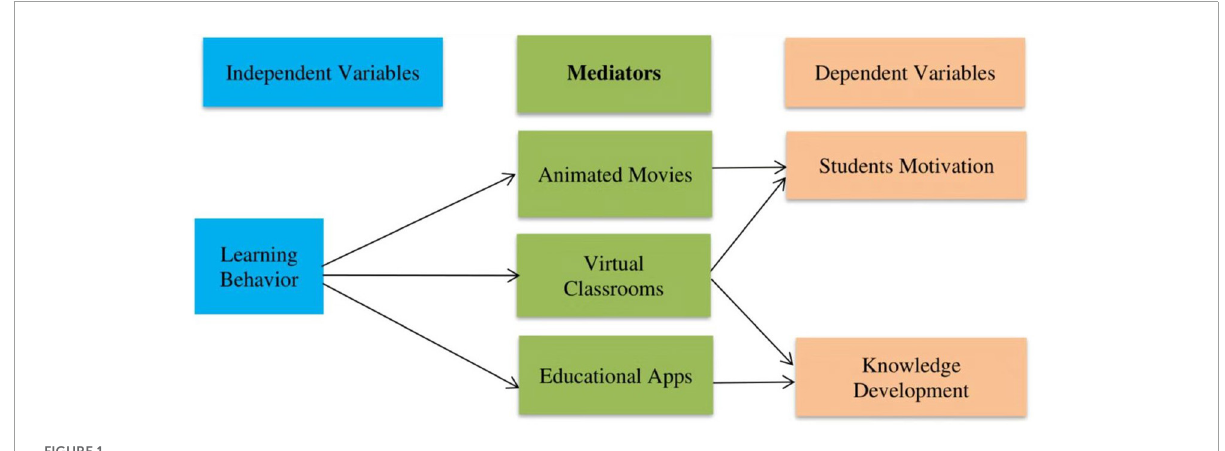
FIGURE1 The relationship between different variables of the